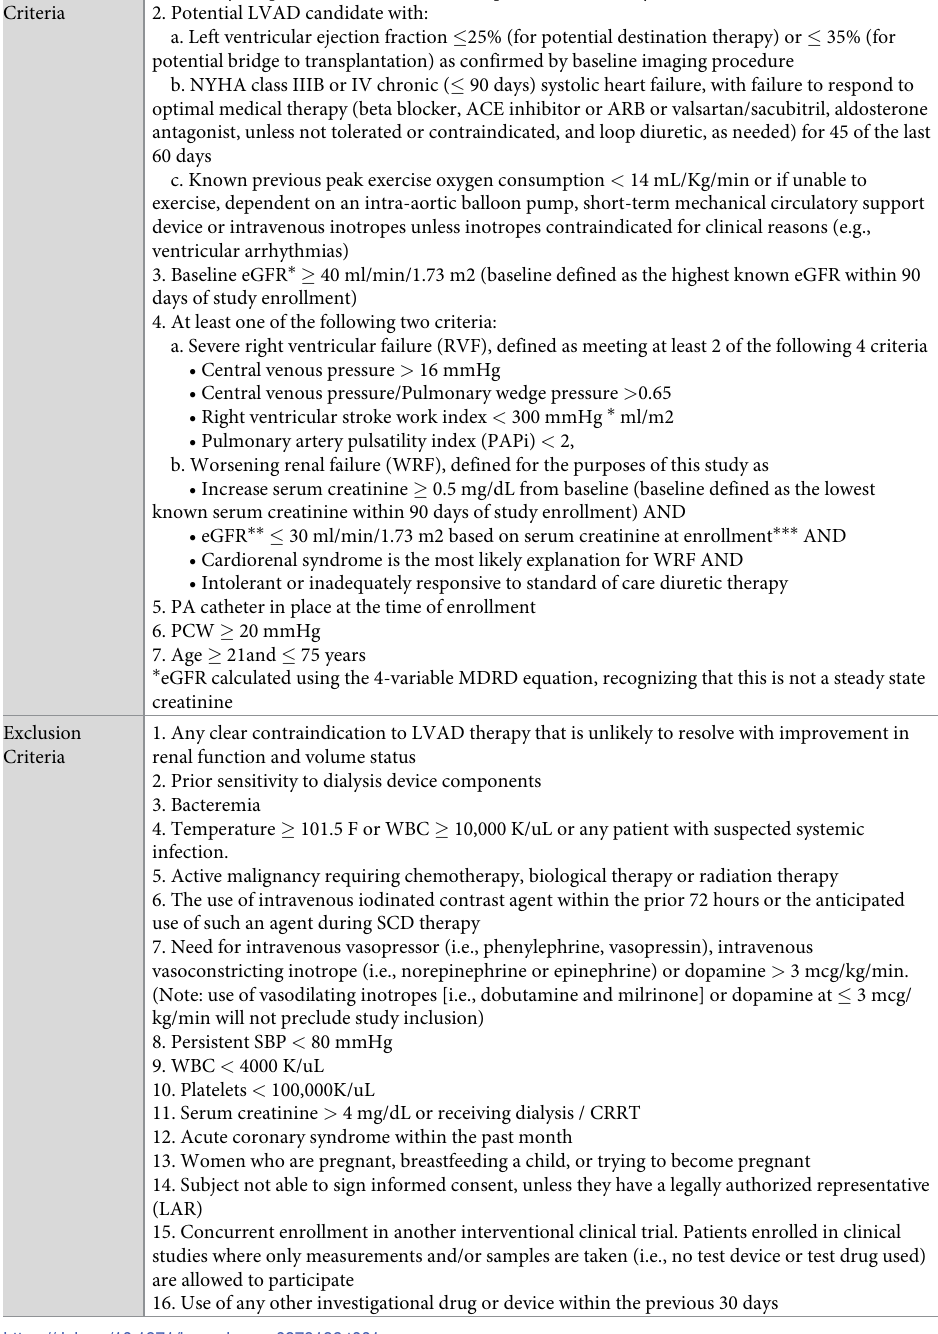
Table 1. Inclusion and exclusion criteria of clinical